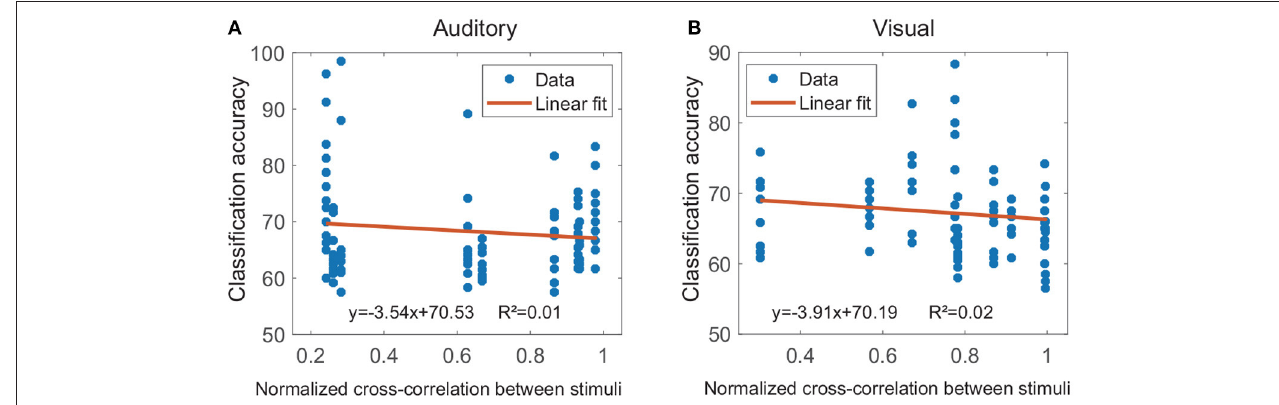
FIGURE 6 | Results of the linear regression analyses between the physical difference of stimuli and the classification accuracy. The physical difference of stimuli was evaluated by the cross-correlation value, and several cross-modal regions of the same subject shared the same cross-correlation value for each modality. (A,B) Show results for the auditory modality and visual modality, respectively ( p < 0.001).